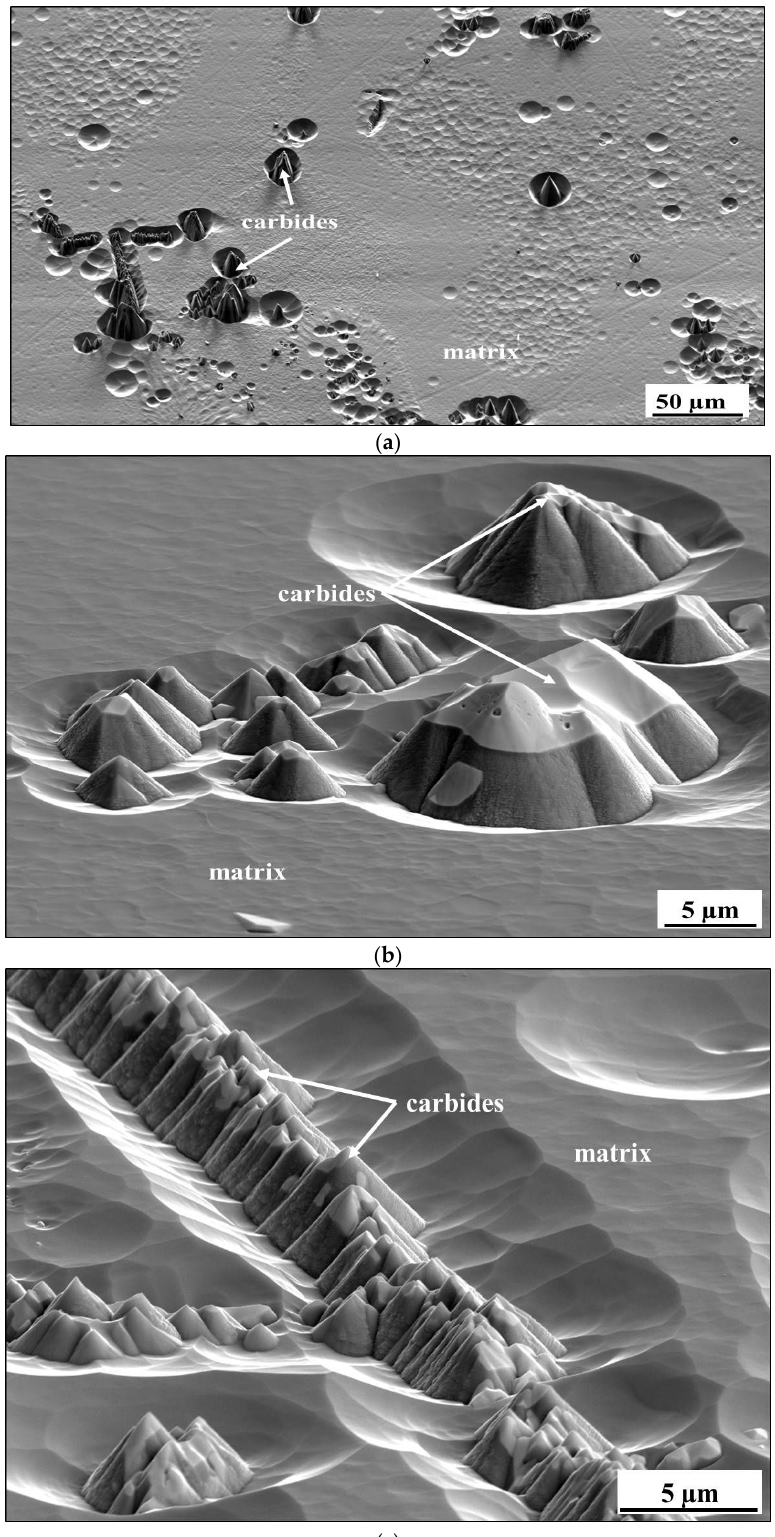
Figure 12. SEM/BSE images of the bottom of the sputtered area on the cross-section of CM247 after air oxidation at 1050 ◦ C for 20 h showing: ( a ) an overview of the crater bottom, ( b ) single carbides and ( c ) carbides located at the grain boundaries of